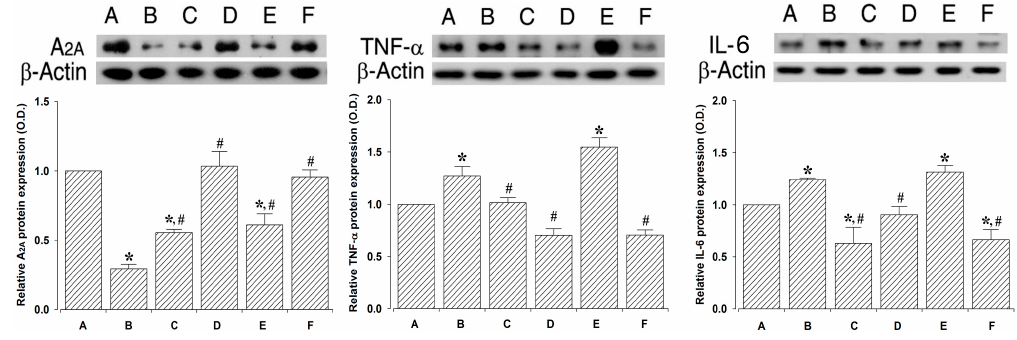
Figure 5. Effect of polydeoxyribonucleotide (PDRN) treatment on the adenosine A 2A receptor, tumor necrosis factor- α (TNF- α ), and interleukin-6 (IL-6) expressions. Actin was used as an internal control (46 kDa). Upper : The results of ban detection using the enhanced chemiluminescence (ECL) detection kit. ( A ) Control and 24 h after sacrifice group; ( B ) Lung injury and 24 h after sacrifice group; ( C ) Lung injury with PDRN-treatment and 24 h after sacrifice group; ( D ) Control and 72 h after sacrifice group; ( E ) Lung injury and 72 h after sacrifice group; and ( F ) Lung injury with PDRN-treatment and 72 h after sacrifice group. Lower : The relative expressions of adenosine A 2A receptor ( left ), TNF- α ( middle ), and IL-6 ( right ) in each group. * represents p < 0.05 compared to the control and 24 h after sacrifice group. # represents p < 0.05 compared to the lung injury and 24 h after sacrifice group.